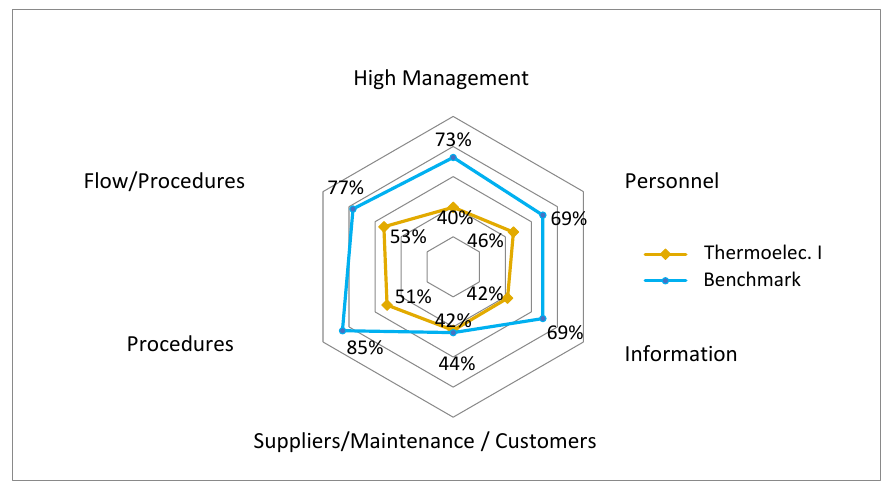
Figure 3. Lean performance comparison between Thermoelectric Plant I and its benchmark.